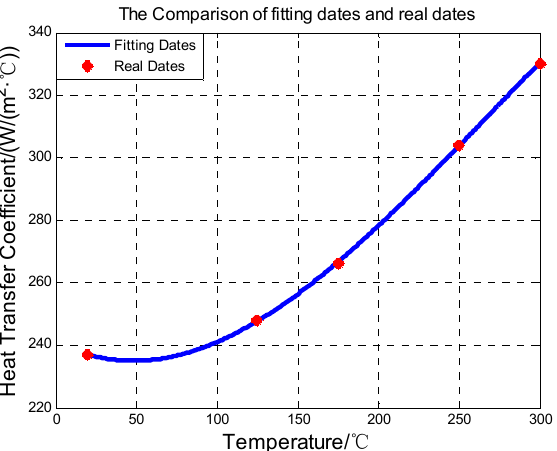
Figure 5. The cubic polynomial fitting curve of real heat transfer coefficient. Table 7 shows the design space of identified parameters. Table 7. The range of design space of identified parameters.